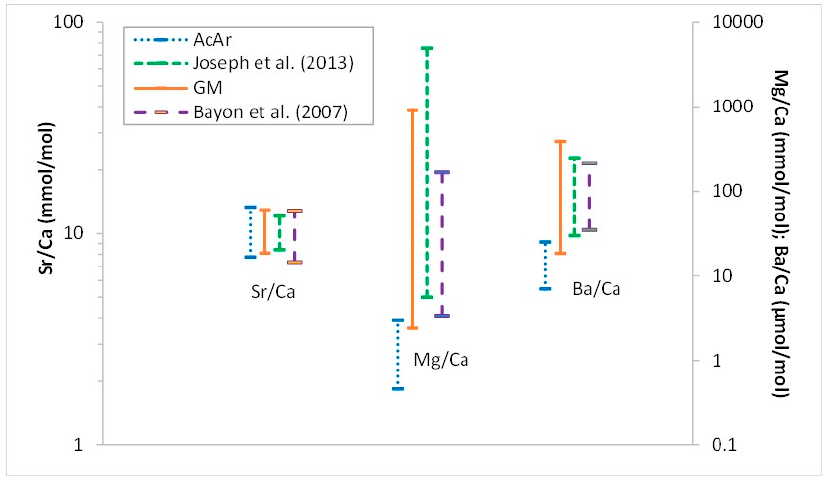
Figure 5. Comparison of Mg/Ca, Sr/Ca, and Ba/Ca between cement (GM), AcAr, and literature data.